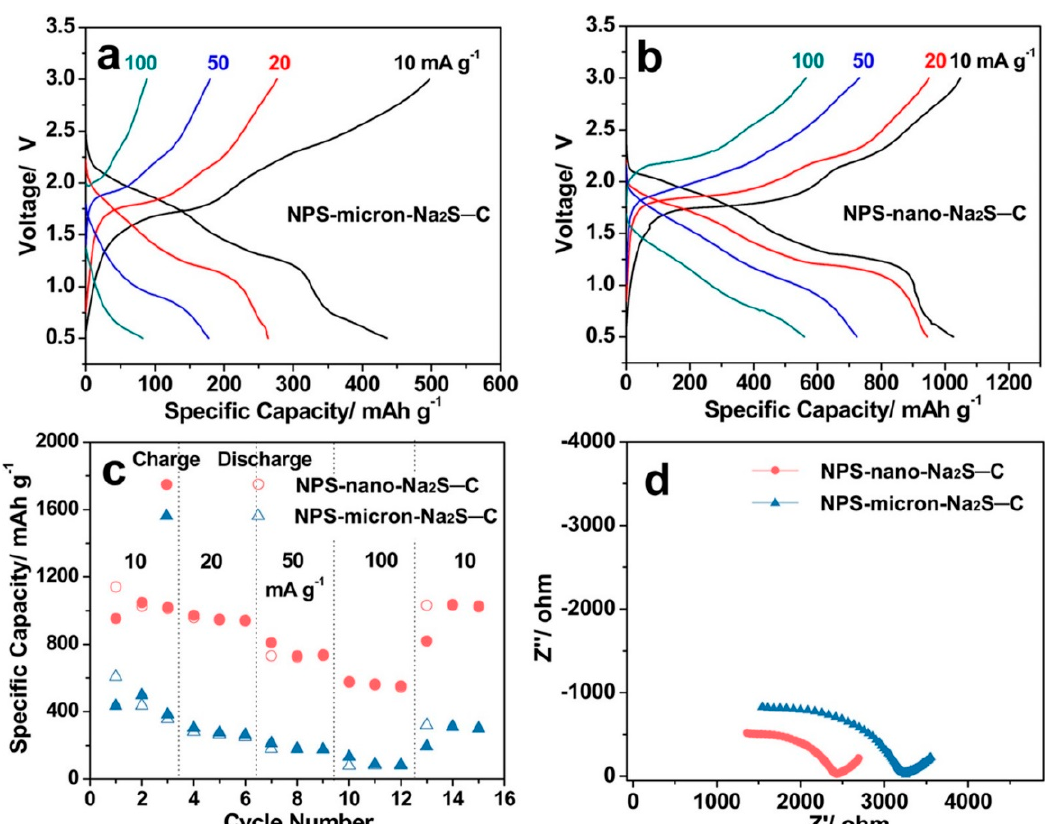
Figure 11. ( a ) Ionic conductivity of PEO–NaTFSI-based electrolyte at different EO:Na + ratios; ( b ) ionic conductivity of PEO–NaTFSI/Na 3 Zr 2 Si 2 PO 12 at various weight ratios of Na 3 Zr 2 Si 2 PO 12 ; ( c ) Ac impedance and chronoamperometry of Na|| PEO–NaTFSI ||Na cell; ( d ) equivalent circuit used to fit the impedance data. (Reprinted with permission from [144]; Copyright 2022, ChemistrySelect 2022 , 7 .)